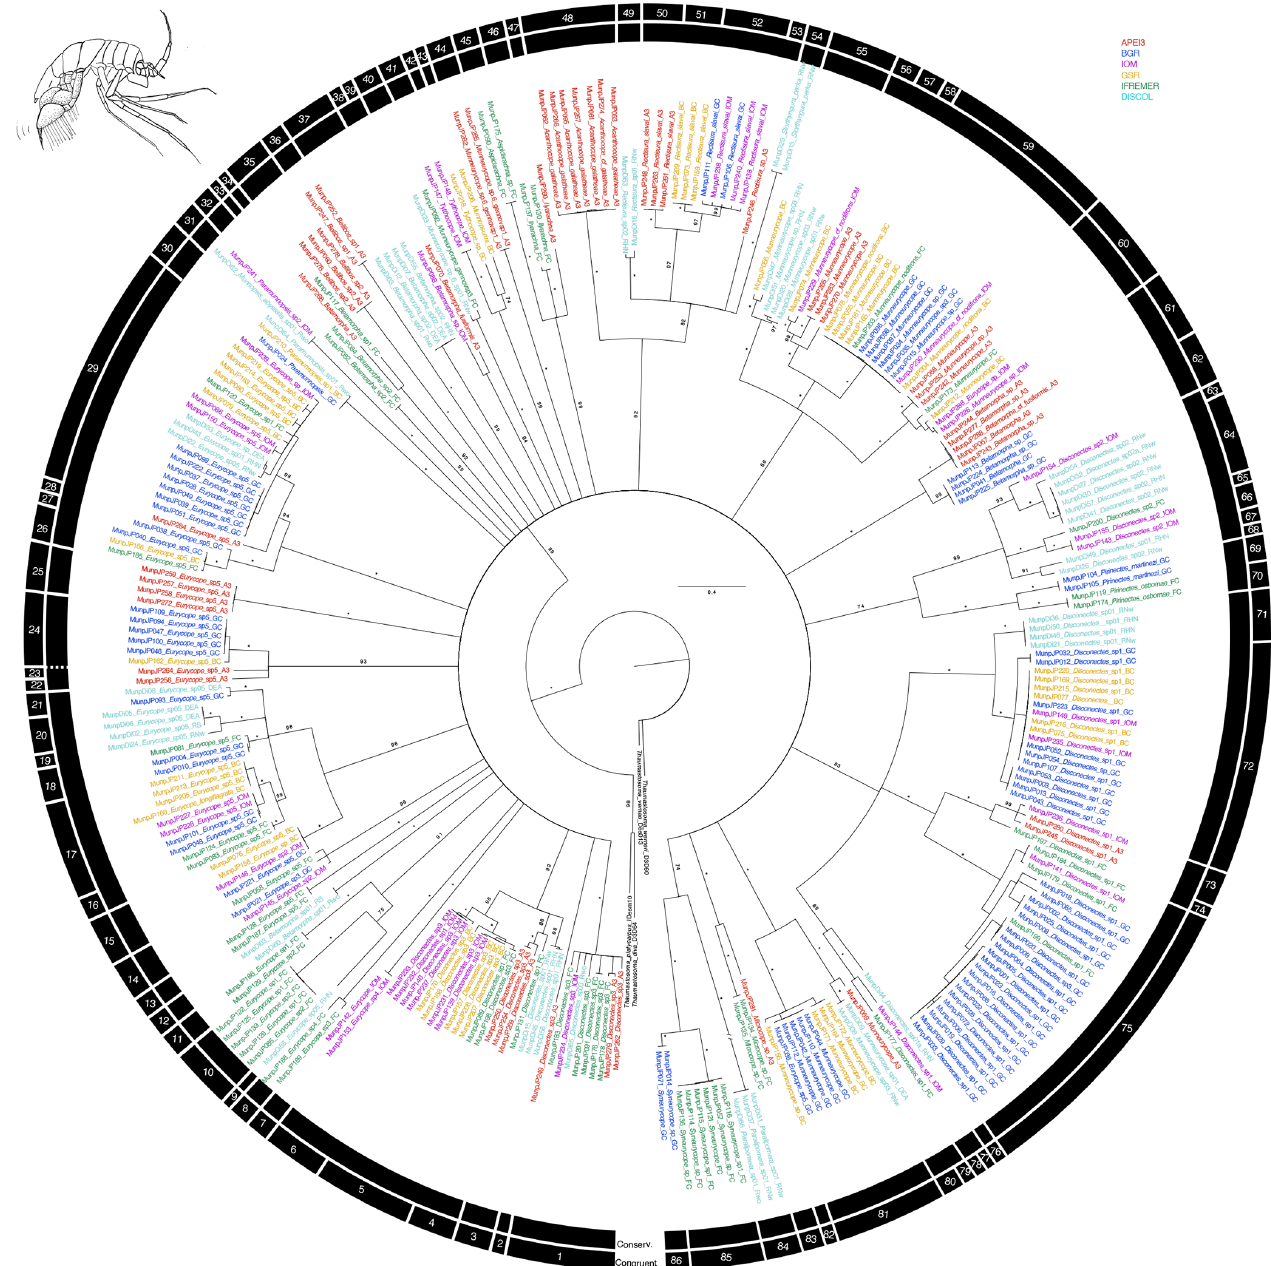
Figure 3. Phylogenetic tree of all munnopsid samples based on 16S and COI sequences for 294 specimens. Colors indicate collection location with black indicating outgroups. All unsupported branches were collapsed, and bootstrap support is indicated with asterisks indicating 100% bootstrap support. The outer two bars summarize the results of the species delimitation analyses which included morphological determination, VSEARCH for individual genes, ABGD for individual genes, and PTP and mPTP for both individual genes and the concatenated datasets. The conservative bar indicates that all SD analyses supported that split, while the congruent bar indicates that the majority of SD analyses showed that split. Numbers on congruent bars are arbitrary and are provided to allow a way to refer to specific supported